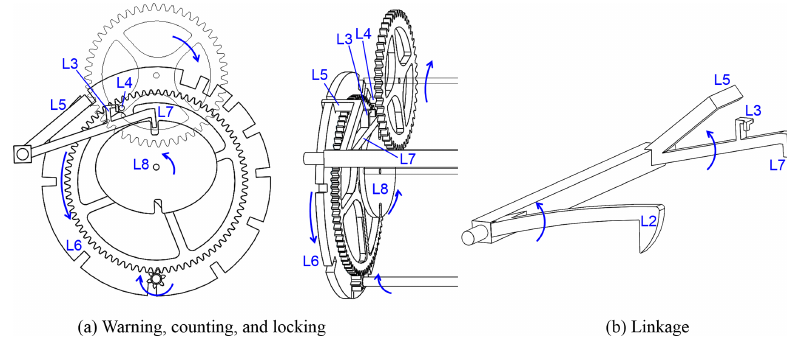
Figure 26. Structure and operation of the N9 striking trigger. (The trigger is similar to that of N5.)